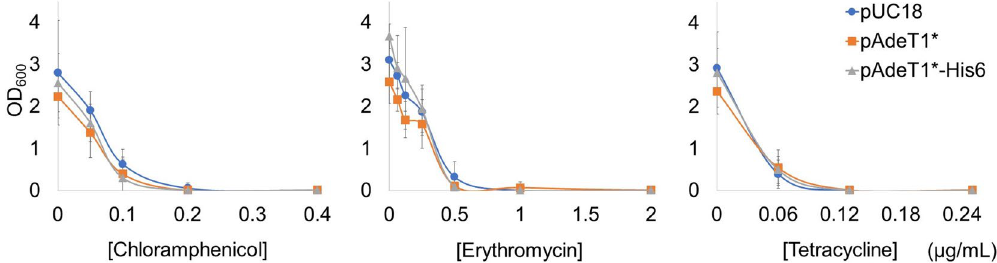
Figure 3. MIC testing of E. coli KAM32 cells carrying either pUC18, pAdeT1* or pAdeT1*-His6. Each data point represents an average of six biological replicates with the standard deviation. Optical density values were recorded on a Victor X (Perkin Elmer) microplate reader and converted to standard OD 600 values using a calibration curve. Averages and standard deviations of the raw data are provided in Supplementary Tables S1–3, while the OD 600 calibration curve is provided in Supplementary Fig.